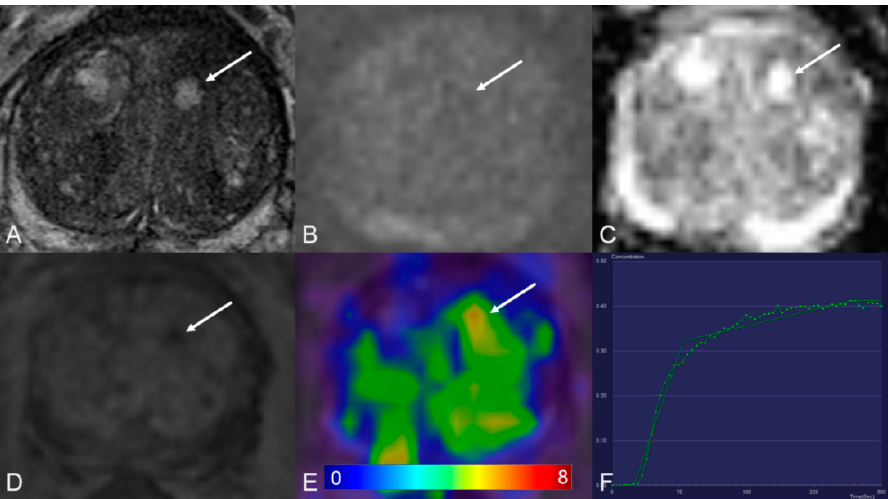
Figure 1. Transition zone with a PI-RADS 1 change. ( A ) Axial T2WI shows typical benign prostatic hyperplasia (BPH) change. ( B ) DWI (b = 1000 s/mm 2 ) shows no lesion with a marked hyperintense signal above the background. ( C ) ADC map image presents no diffusion restriction. ( D ) Early dynamic contrast-enhanced image presents no enhancement within the typical BPH nodule. ( E ) [ 68 Ga]Ga-PSMA-11 PET/MRI fusion image shows moderate [ 68 Ga]Ga-PSMA-11 uptake, with SU- Vmax of 6.3. ( F ) DCE-MRI time-intensity curve demonstrates persistent increase enhancement. AT: 0.39 min; TTP: 1.09 min; W-in: 0.16; W-out: 0.02; PEI: 0.25; iAUC: 0.10.